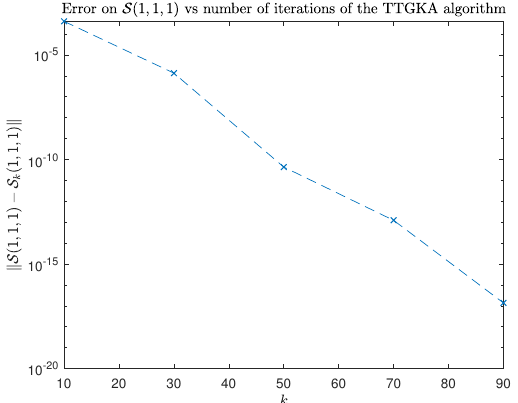
Figure 2. (cid:107) Σ ( 1,1,1 ) − S ( 1,1,1 ) (cid:107) vs. number of TTGGKA iteration k .